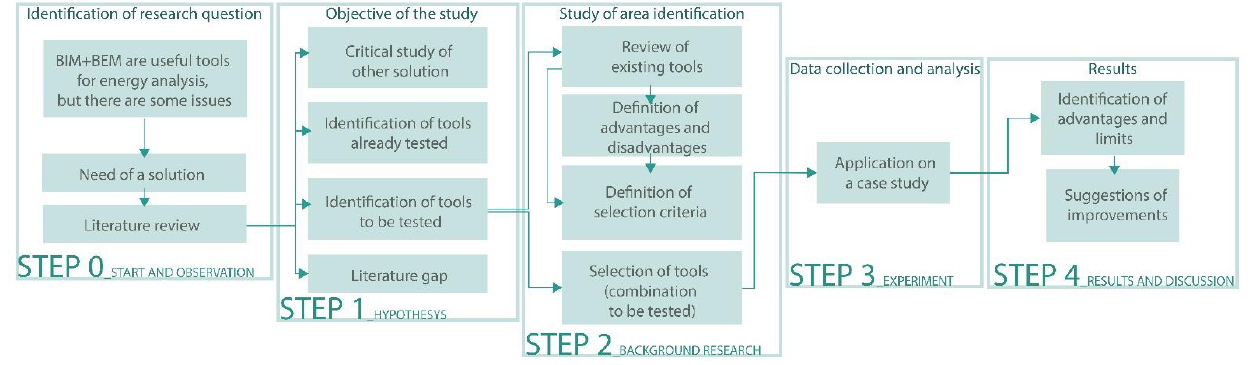
Figure 1. Workflow diagram with research framework.